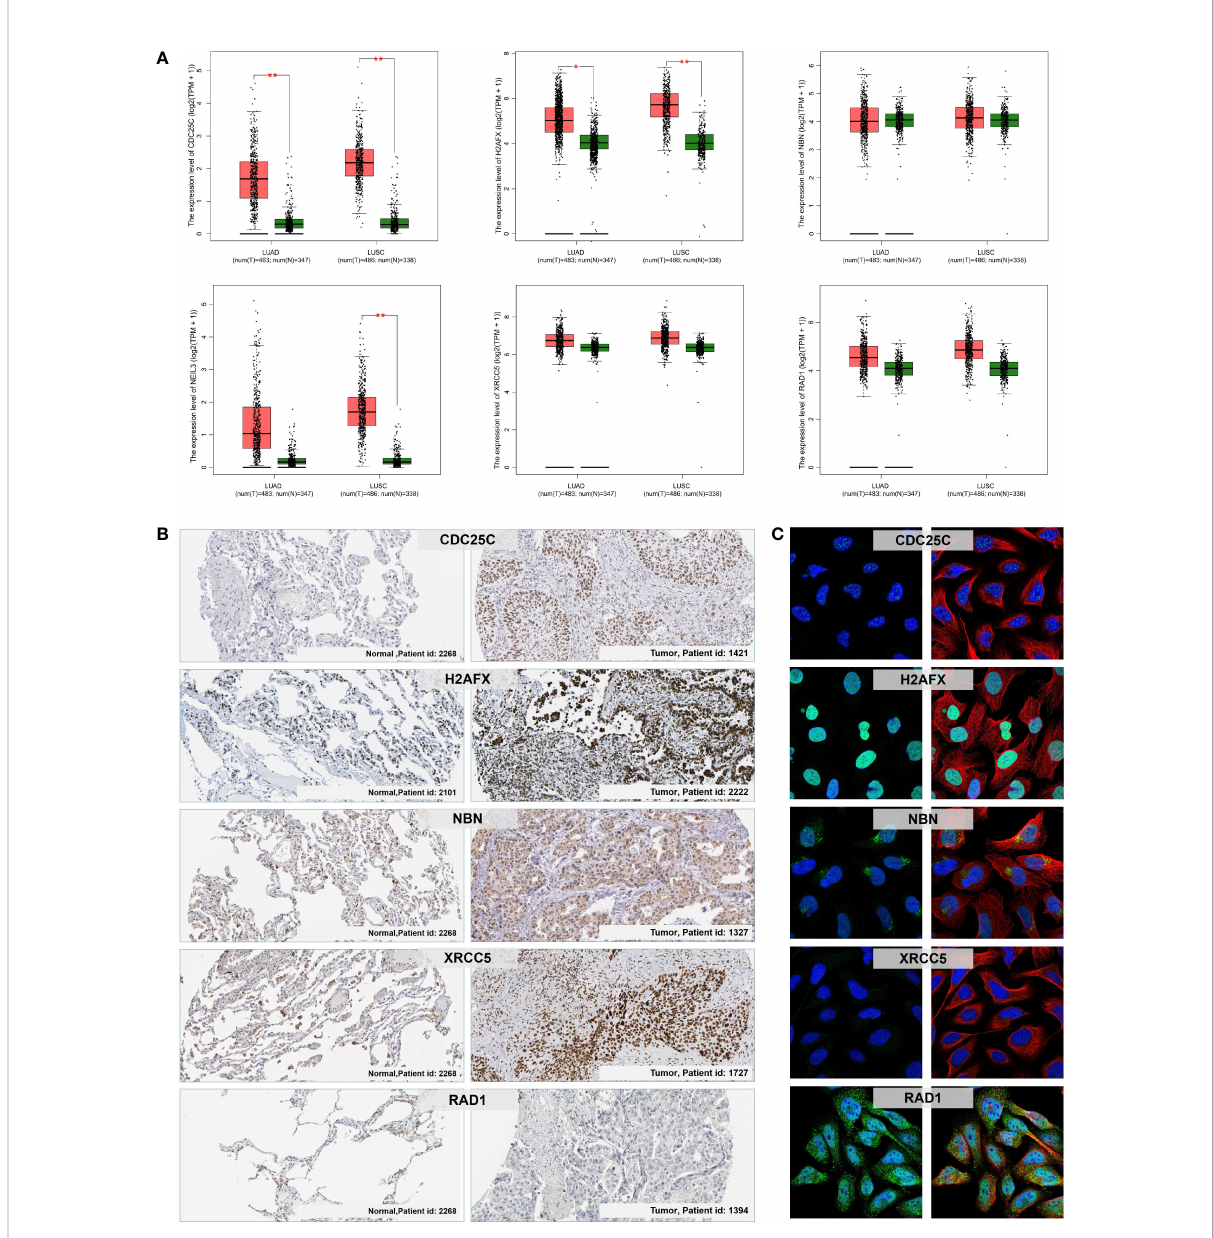
FIGURE 9 mRNA and protein expression levels of the prognostic DDR-related signature genes in NSCLC. (A) The mRNA expression of CDC25C, NEIL3, H2AFX, NBN, XRCC5, and RAD1 in normal lung and NSCLC (LUAD and LUSC) tumor tissues via the GEPIA. *p < 0.05; **p < 0.01. (B) Immunohistochemistry analysis showing the protein expression of the signature genes in normal lung and NSCLC tumor tissues obtained from the HPA database (data for NEIL3 were not available). (C) Immuno fl uorescence images of CDC25C, H2AFX, NBN, XRCC5, and RAD1 in cells with green, blue, and red indicating target proteins, nuclei, and microtubules,